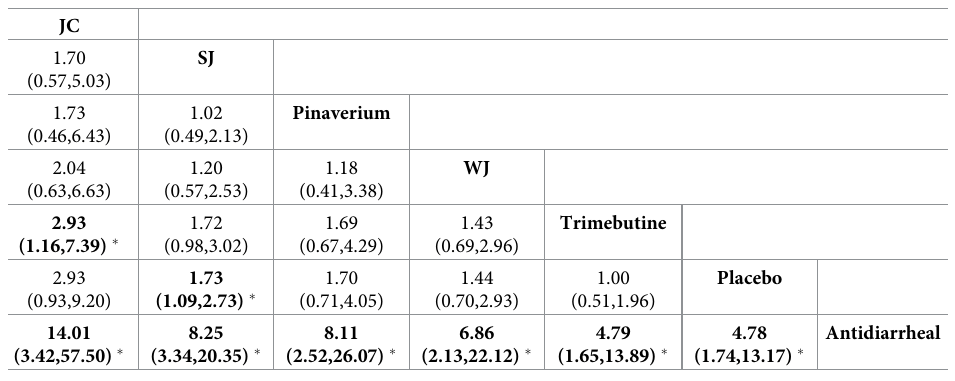
Table 5. Standard mean difference with 95% confidence interval of irritable bowel syndrome symptom severity